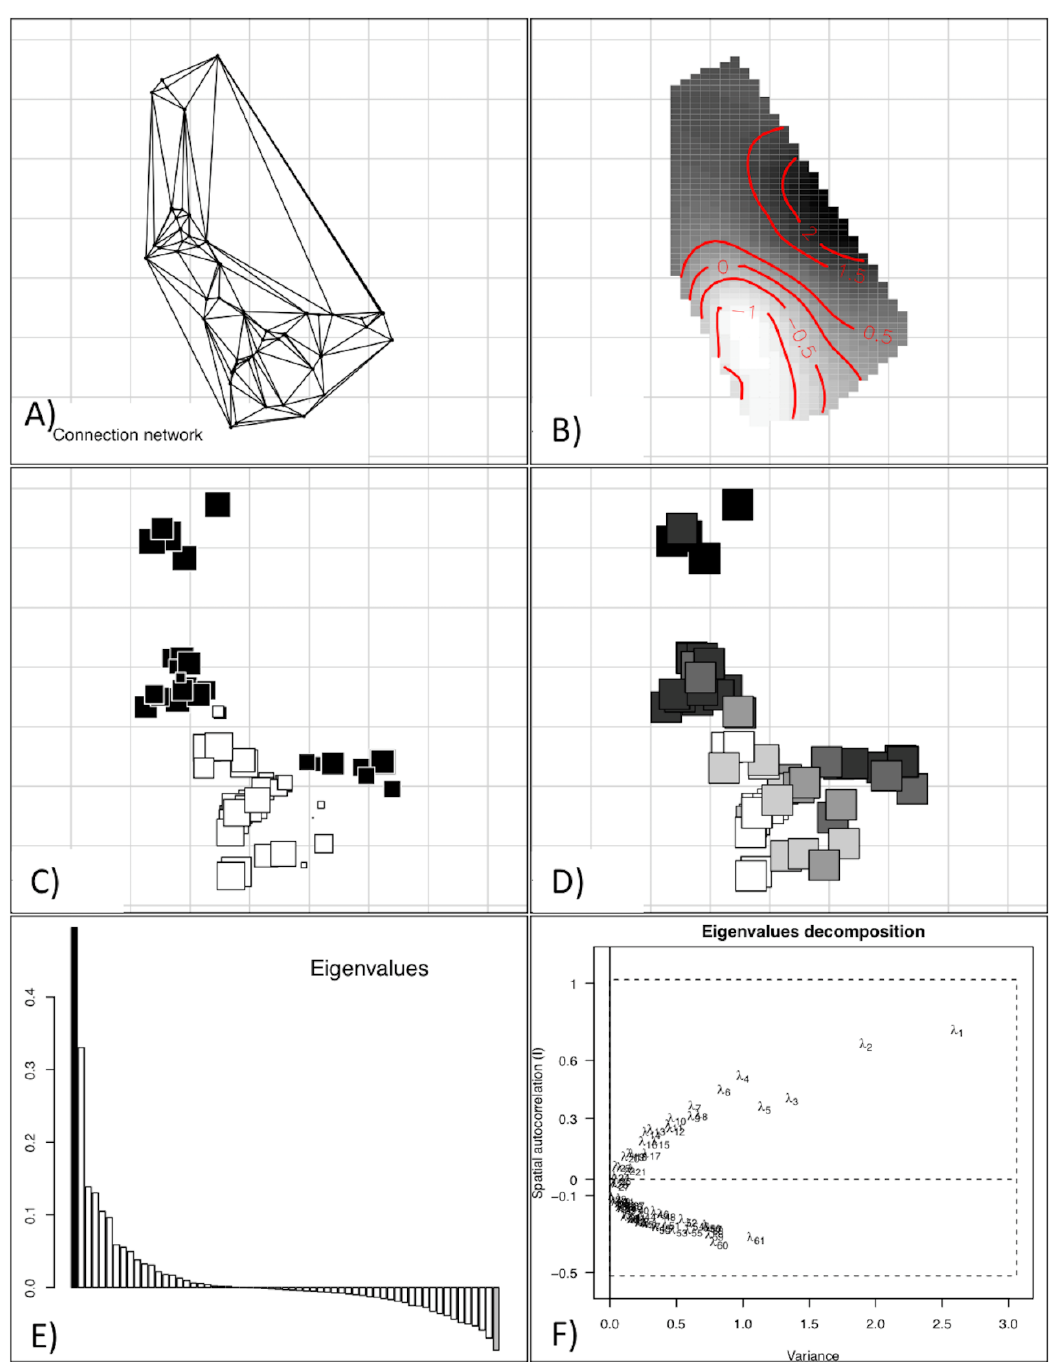
Figure A1.4 Spatial Principal Components Analysis of grizzly bear population structure for female bears conducted with a A) Delauney Connection Network and producing B-D) three representations of the first score and E-F) two eigenvalue